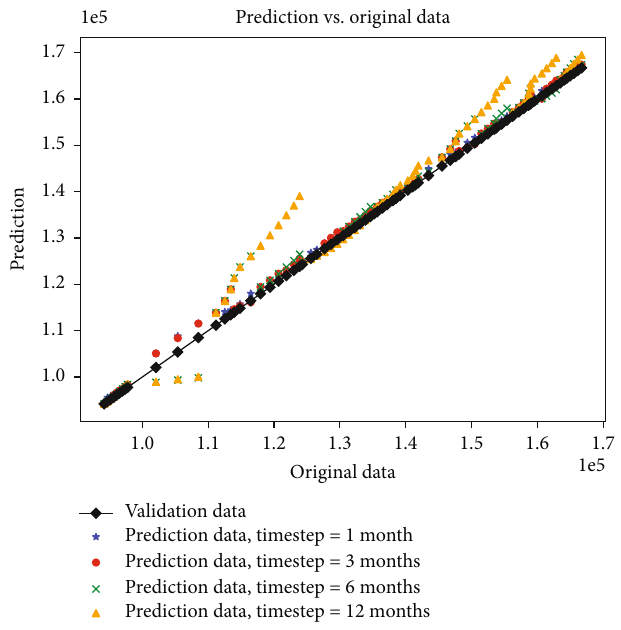
Figure 19: Cross-plot of prediction and cumulative oil data. The scale of the x - and y -axes is in an order of 10 5